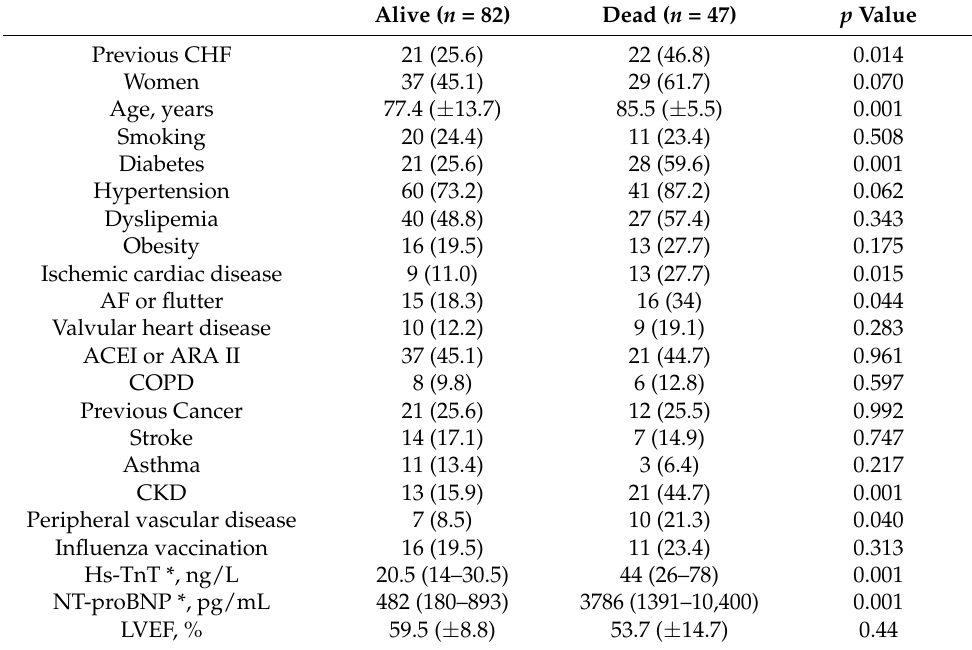
Table 3. Comparison of baseline characteristics between patients alive and dead during hospitalization.